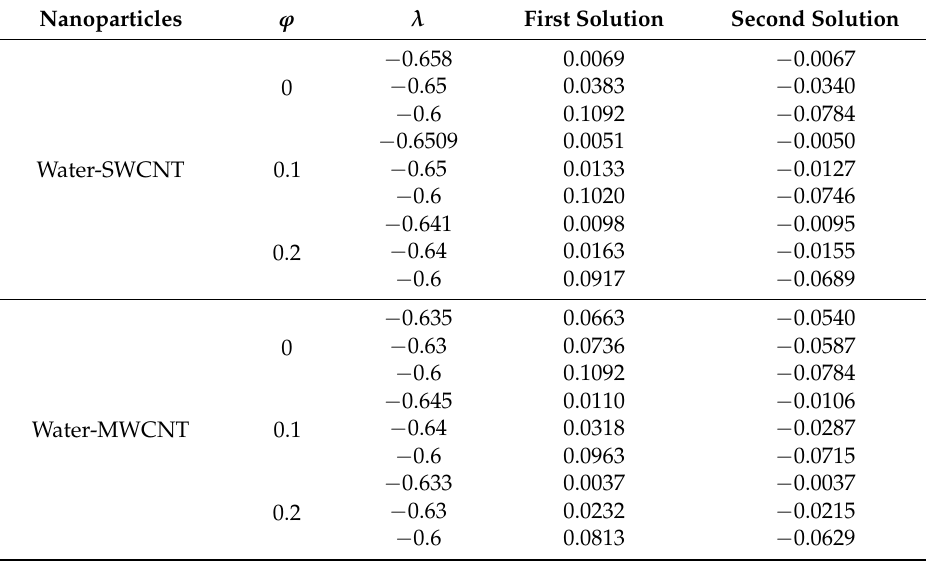
Table 4. Smallest eigenvalues γ at selected values of ϕ and λ for different nanoparticle when σ = 0.2. Nanoparticles ϕ λ First Solution Second Solution − 0